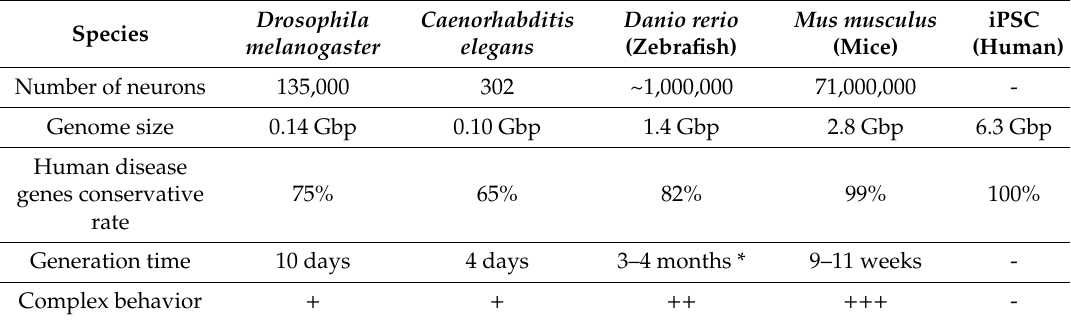
Table 2. Comparisons of model animals and patient-derived induced pluripotent stem cell (iPSC).